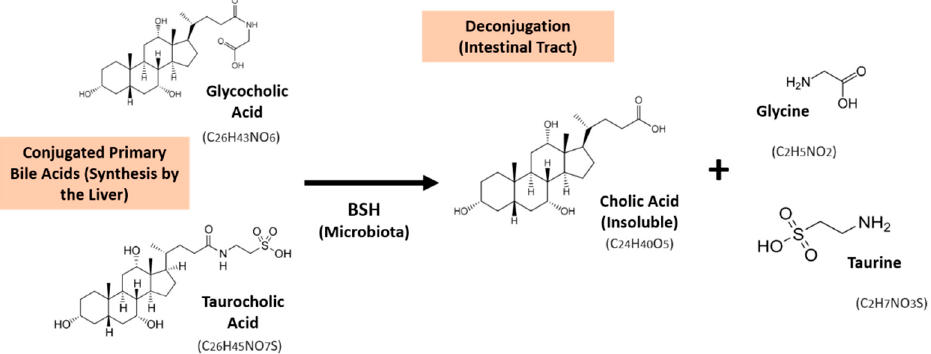
Figure 1. Deconjugation reaction of the glycocholic and taurocholic acids by the microbial bile salt hydrolase (BSH) present in the intestinal tract. A similar reaction occurs for the deconjugation of the secondary bile salts (glycodeoxycholic and taurodeoxycholic acids).